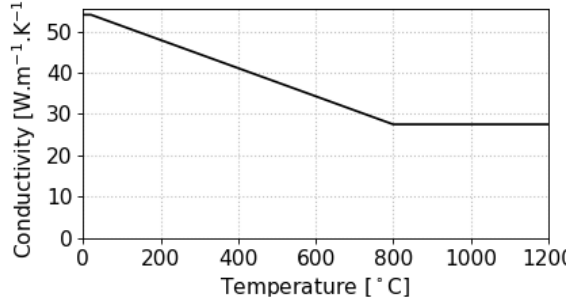
Figure 10. EC3 Steel thermal conductivity.